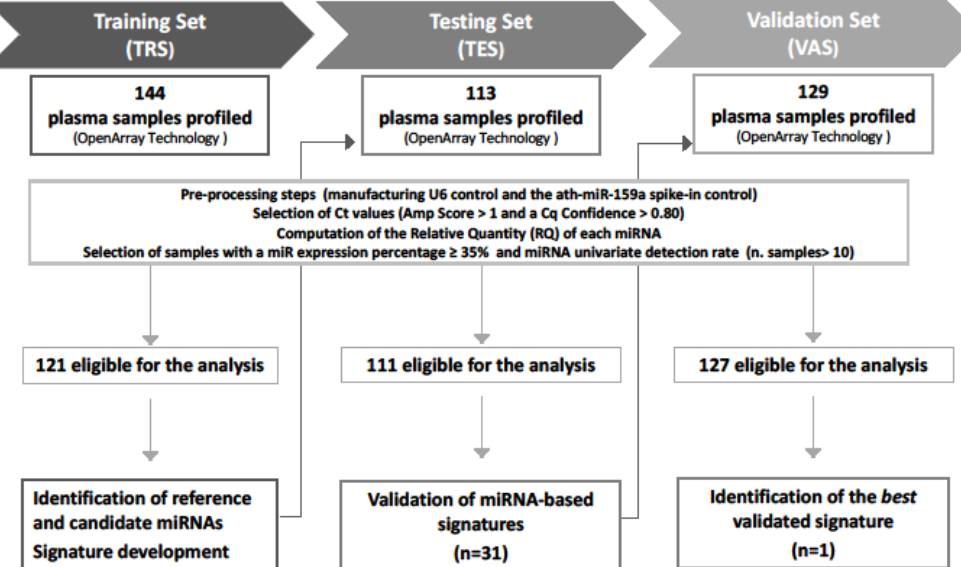
Figure 1. Study workflow. A total of 386 plasma samples were sequentially collected from low-risk PCa patients at the inclusion in AS protocols. The global miRNA expression profiles were assessed by OpenArray technology in all sample sets. Generated data went through preprocessing steps to define samples eligible for the analysis. Training set (TRS) data were analyzed to identify (i) reference miRNAs for normalization and (ii) candidate miRNAs associated with disease reclassification (univariate analysis) and (iii) to develop miRNA signatures. Thirty-one miRNA signatures were then validated in the testing set (TES), and the best signature retaining statistical significance in the validation set (VAS) was identified.